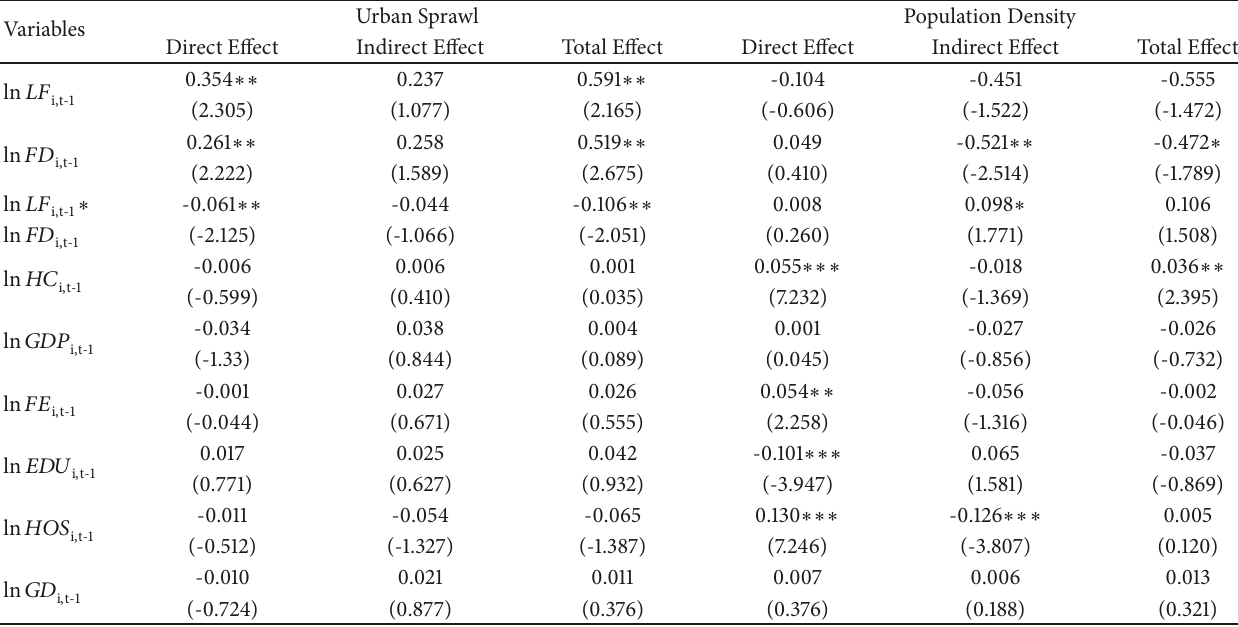
Table 4: The direct, indirect, and total effects of the whole